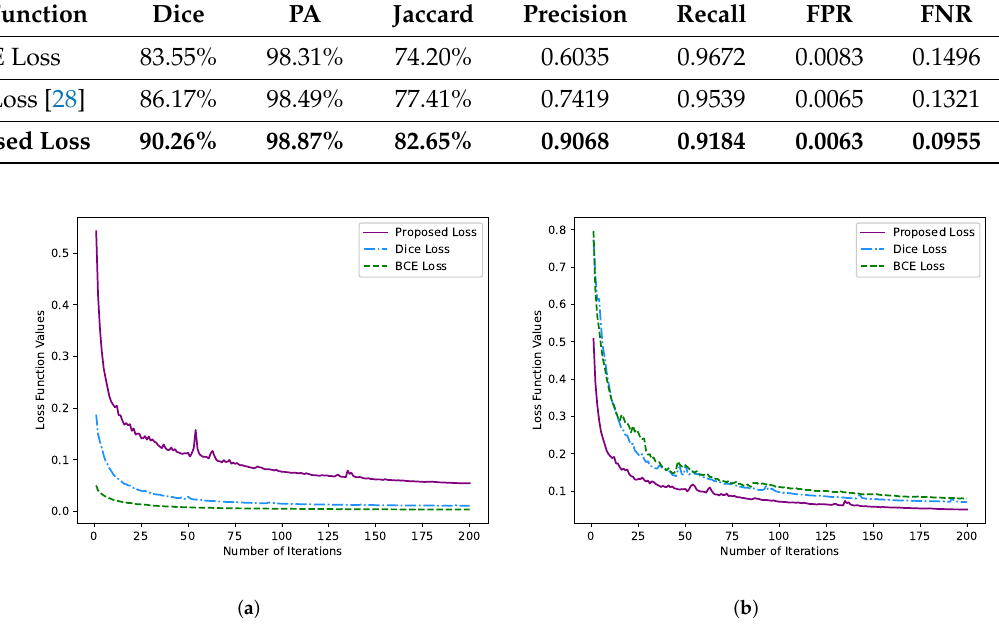
Figure 11. The various loss function curves with the number of iterations. ( a ) Loss function in training stage; and ( b ) Loss function in validation